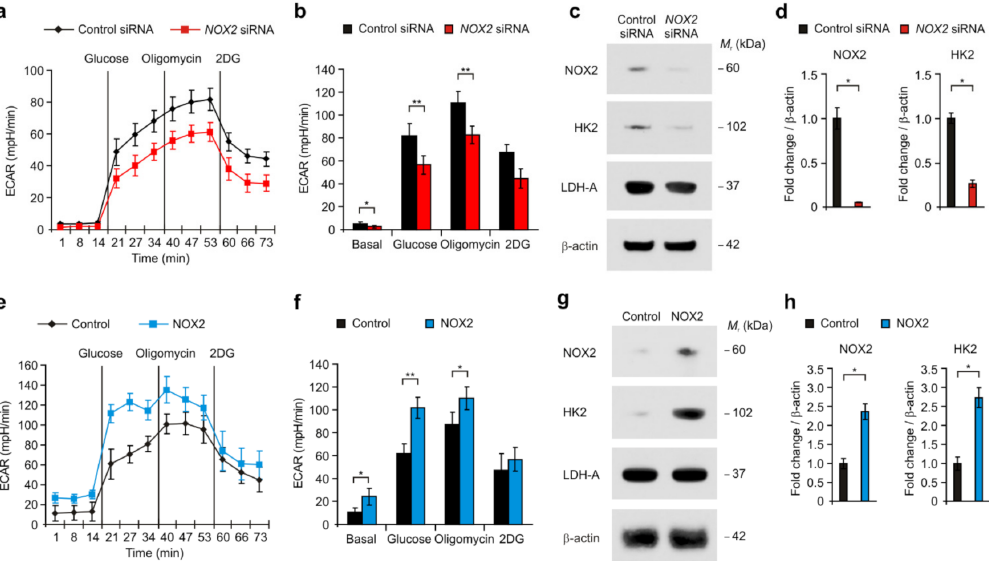
Figure 2. NOX2 induces the activation of HK2-dependent glycolysis in human glioma cells. ( a ) The levels of extracellular acidification rate (ECAR) for glycolysis of glucose and ( b ) quantification of ECAR levels in human glioma cells treated with NOX2 siRNA or control siRNA. ( c ) Representative immunoblot images and ( d ) quantification of NOX2, HK2, and LDH-A protein levels in human glioma cells treated with NOX2 siRNA or control siRNA. β -actin was used as a loading